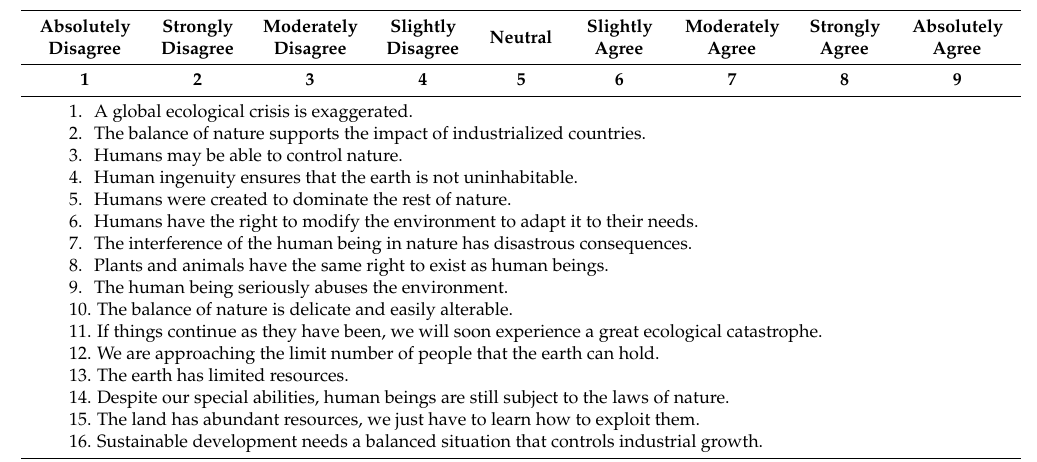
Table 3. Statements of the New Ecological Paradigm Scale.